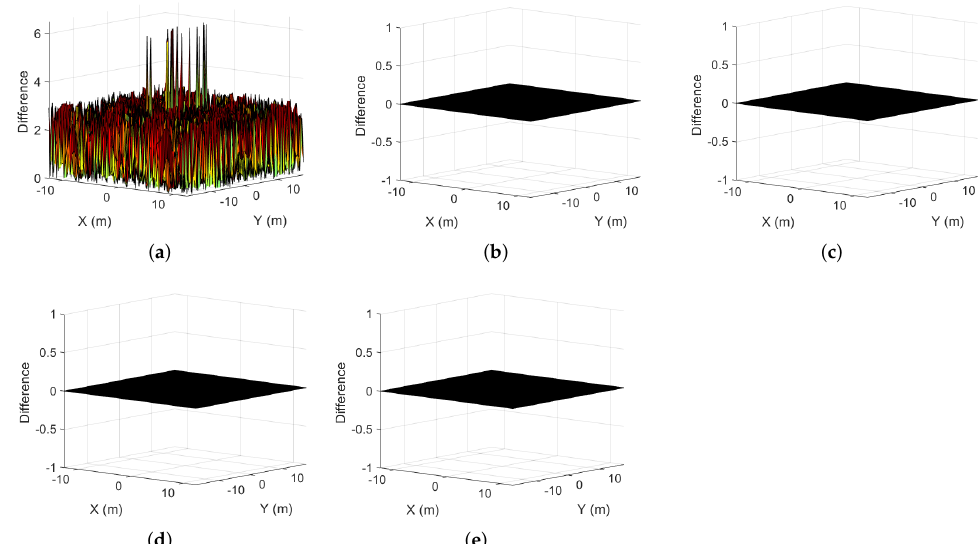
Figure 13. Phase differences. ( a ) The difference between IST and the reference phase. ( b ) The difference between MM- L 1 and the reference phase. ( c ) The difference between MM- L 1/2 and the reference phase. ( d ) The difference between MM- L 0 and the reference phase. ( e ) The difference between GMM- L 0.8 and the reference phase.